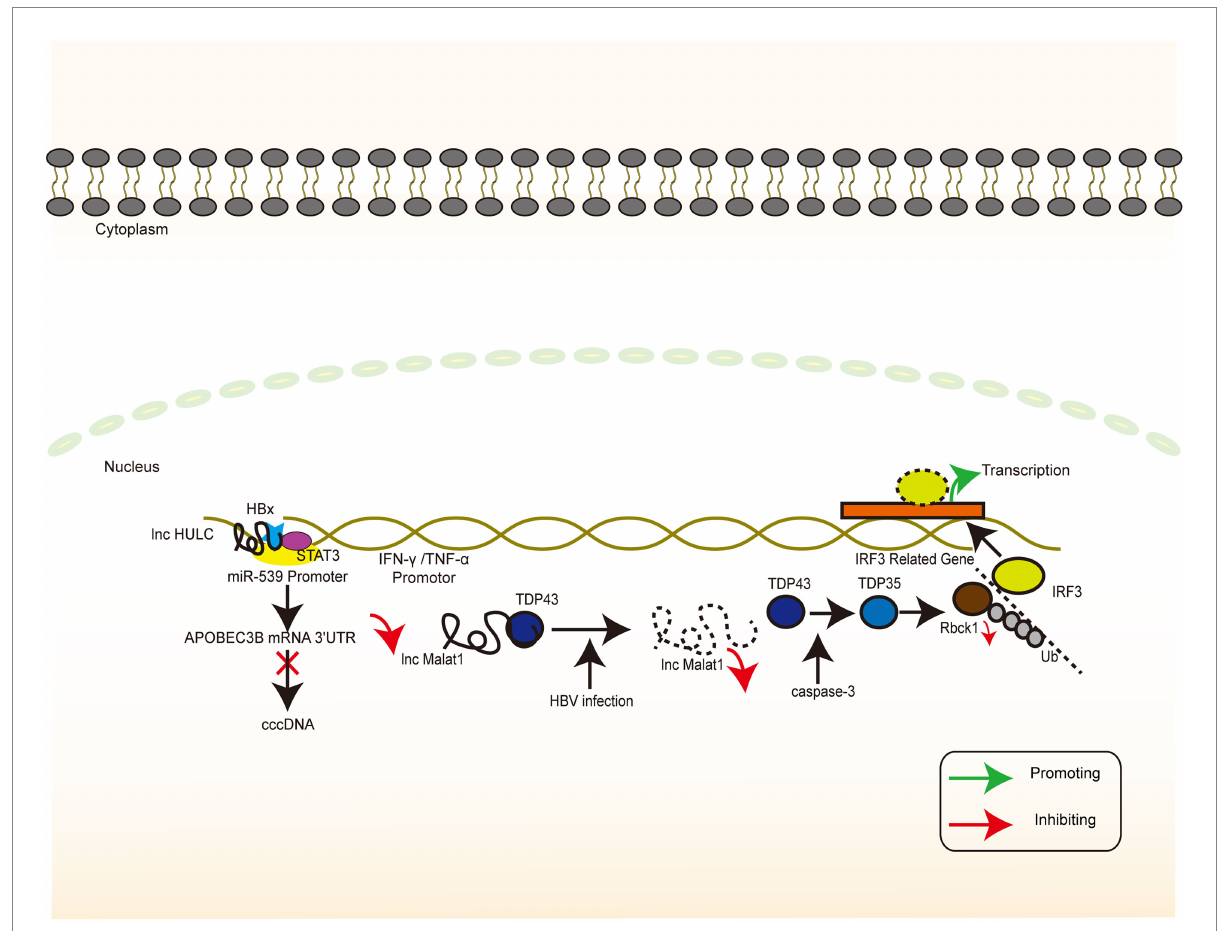
FIGURE 6 HBV-related lncRNAs targeting the host genome (Part II). The signaling pathway of IFN-associated lncRNA whose target of action is located in the host genome. Colour blocks indicate different molecules, irregular lines indicate lncRNA, and large double-stranded lines indicate host genomic DNA. Green arrows indicate the upregulation, while red arrows indicate the